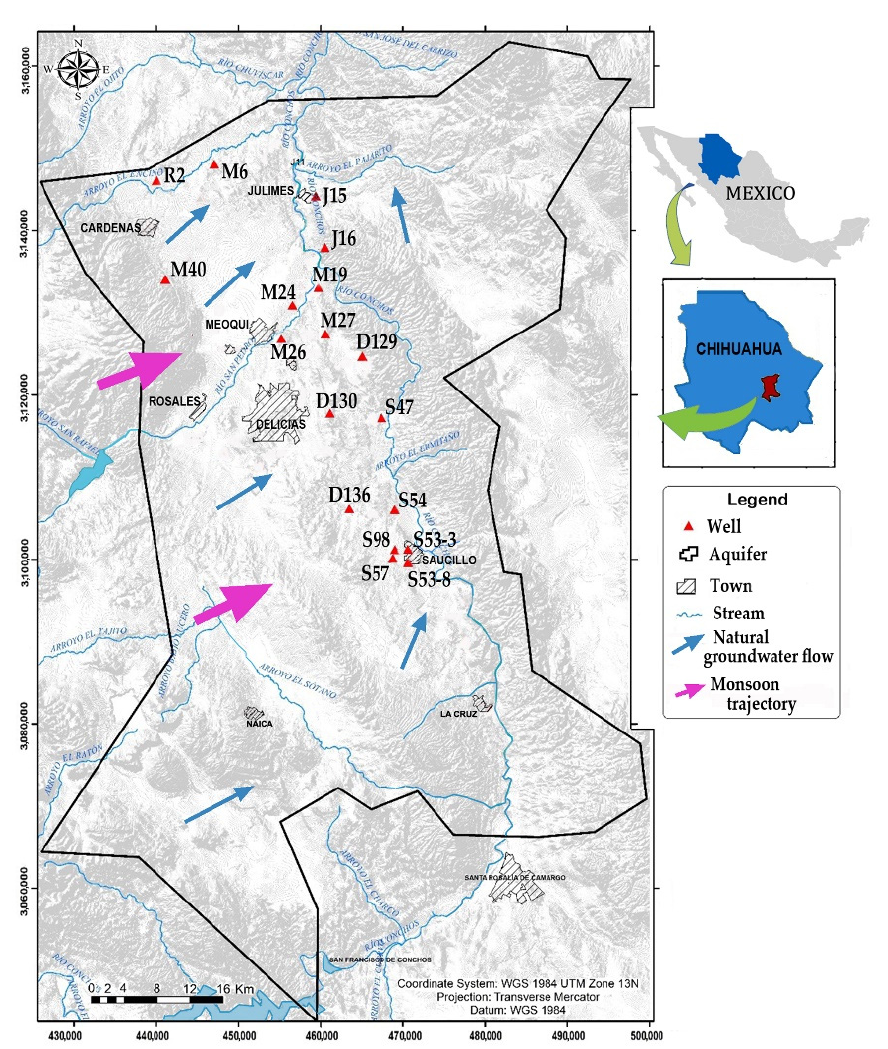
Figure 1. Meoqui-Delicias aquifer and location of the sampled wells. Samples are labeled using the first letter of the nearest community (D for Delicias, M for Meoqui, R for Rosales, J for Julimes, and S for Saucillo) followed by a number.